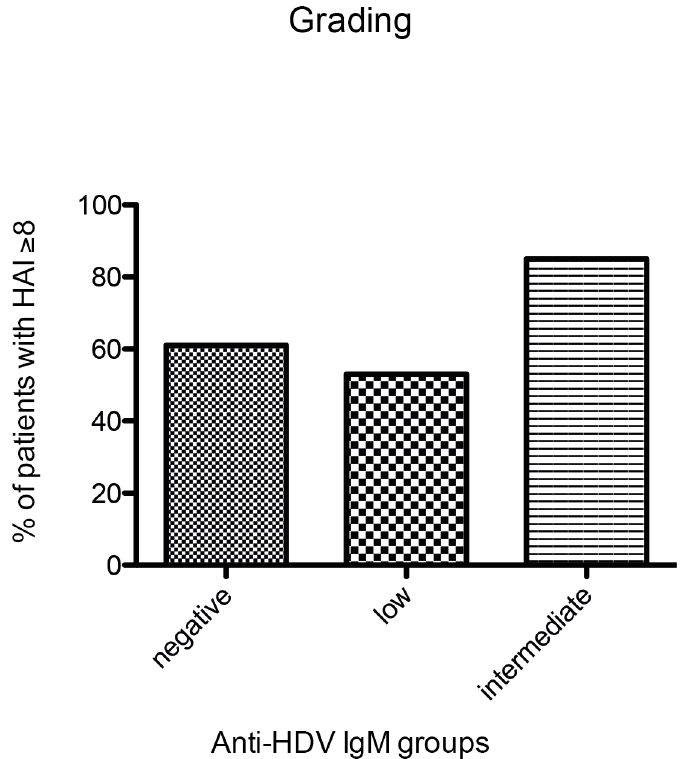
Figure 4. Histological grading of the HIDIT-2 cohort. Diagrammed% of patients with a HAI $ 8 within the anti-HDV IgM groups.